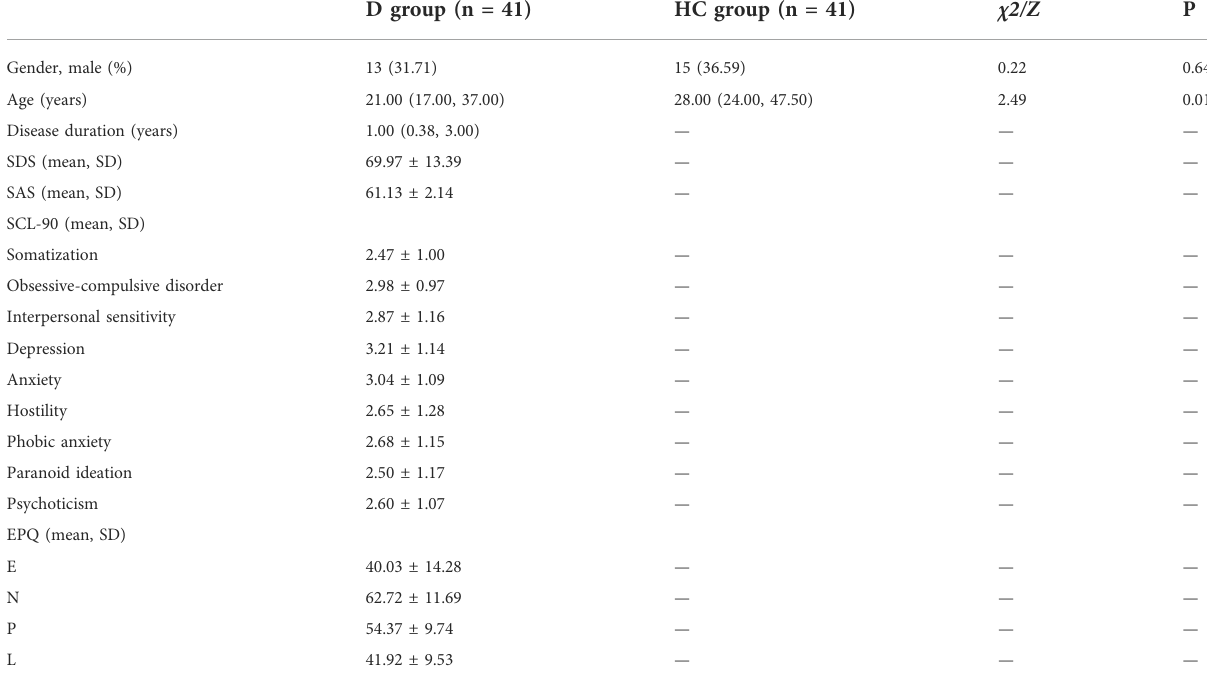
TABLE 1 Clinical and demographic characteristics in the depression group and the healthy control group.